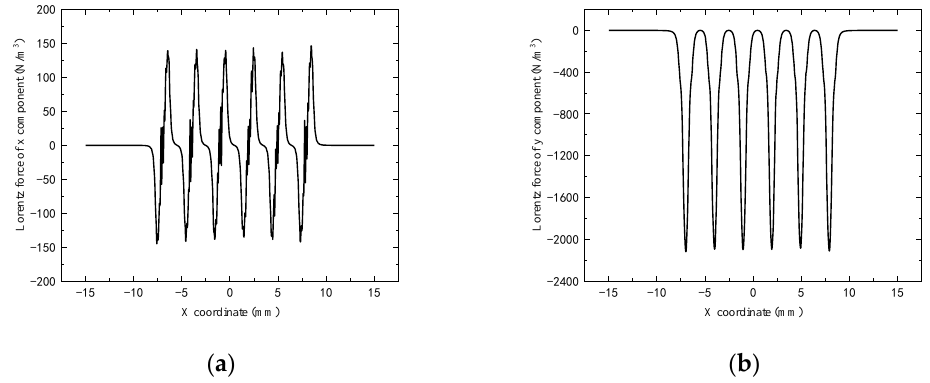
Figure 12. Eddy current distribution in the aluminum plate under the magnet. Figure 13 shows the distribution of the Lorentz force in the x -direction and y -direction produced by the interaction of the induced eddy current and the magnetic field in the skin depth of the aluminum plate. The rectangular magnet mainly provides a vertical magnetic field, so the Lorentz force generated in the aluminum plate by the EMAT is mainly in the x direction. Moreover, due to the edge effect of the magnet, a large vertical Lorentz force is generated in the aluminum plate below the edge of the magnet.